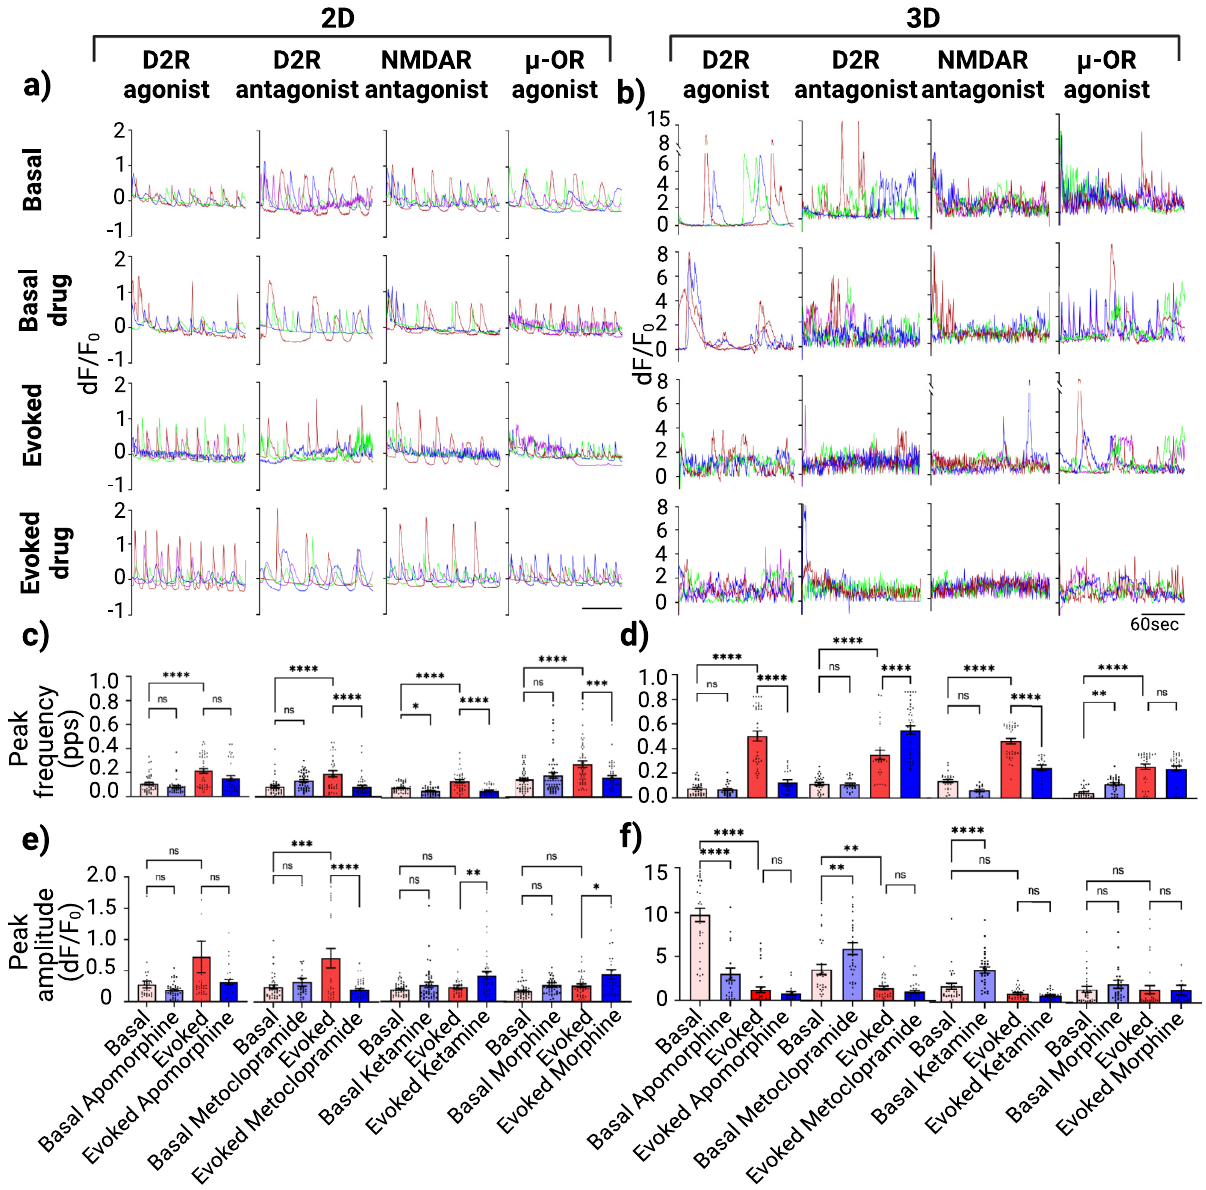
Fig. 6 Pharmacological modulation of image-based single cell calcium fl ux for 2D and 3D iGlutas/iAstros cellular co-cultures. a , b Example of ROIs from different pharmacological treatments in each experimental condition: Basal, Basal with drug, Evoked, Evoked with drug; for the 2D and 3D co-cultures models, respectively. Quantitative measurements of calcium peak frequency ( c , d ) and mean peak amplitudes from each ROIs ( e , f ), the spontaneous and evoked calcium fl ux, for 2D and 3D co-cultures for each drug tested. Minimal of three ROIs from each well and three technical replicates, each with 3 wells per group were plotted as bar graph. Error bar s.e.m., Statistics: Two-way ANOVA with post hoc turkey test between